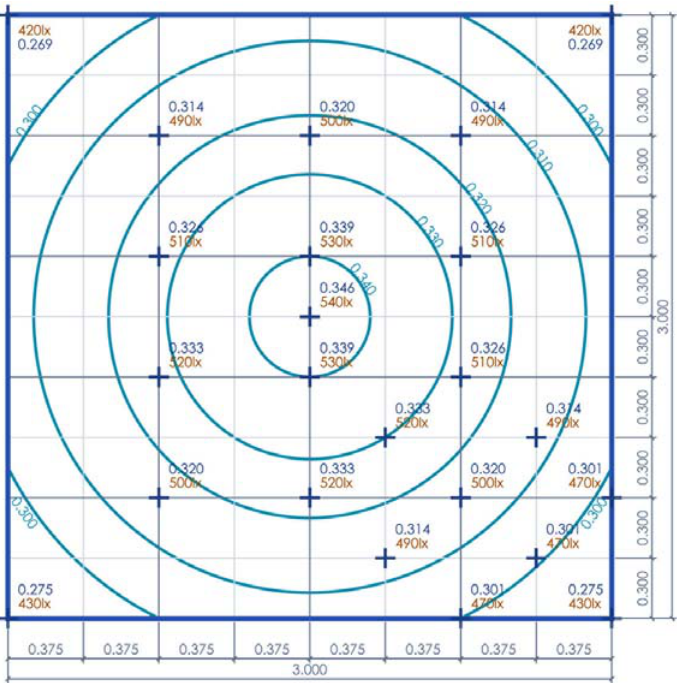
Figure 9. Measurements of the photometer in the scale model of artificial sky.